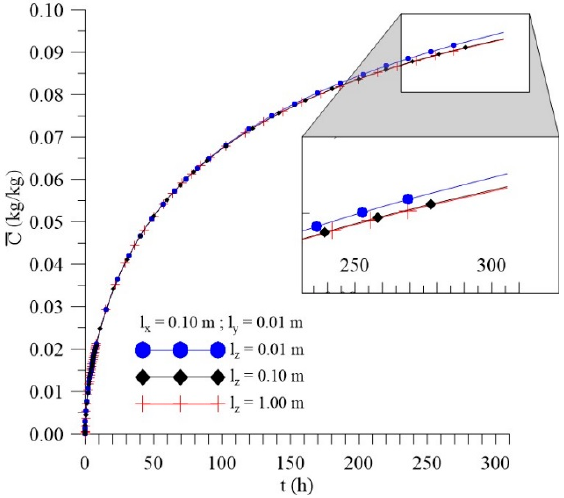
Figure 30. Kinetics of the average free solute concentration for different distances l z (Cases 9, 13, and 14).